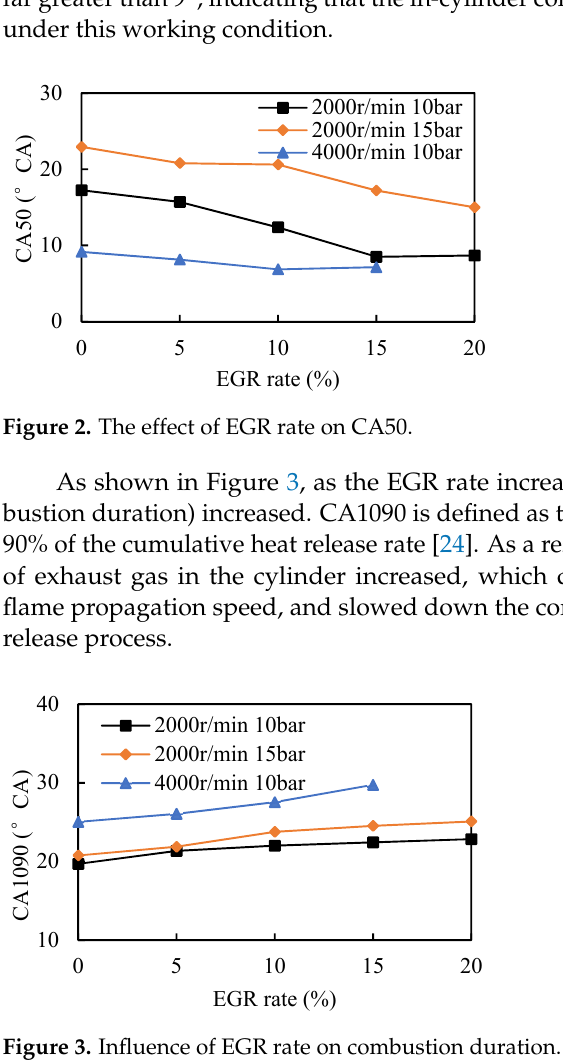
Figure 3. Influence of EGR rate on combustion duration.